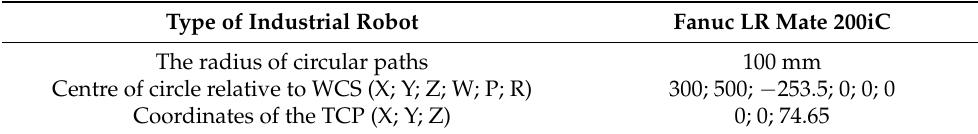
Figure 1. The course of the motion of the individual robot joints during the TCP movement in a circular path in the XY plane. Table 1. Conditions for creating the circle in the XY plane.